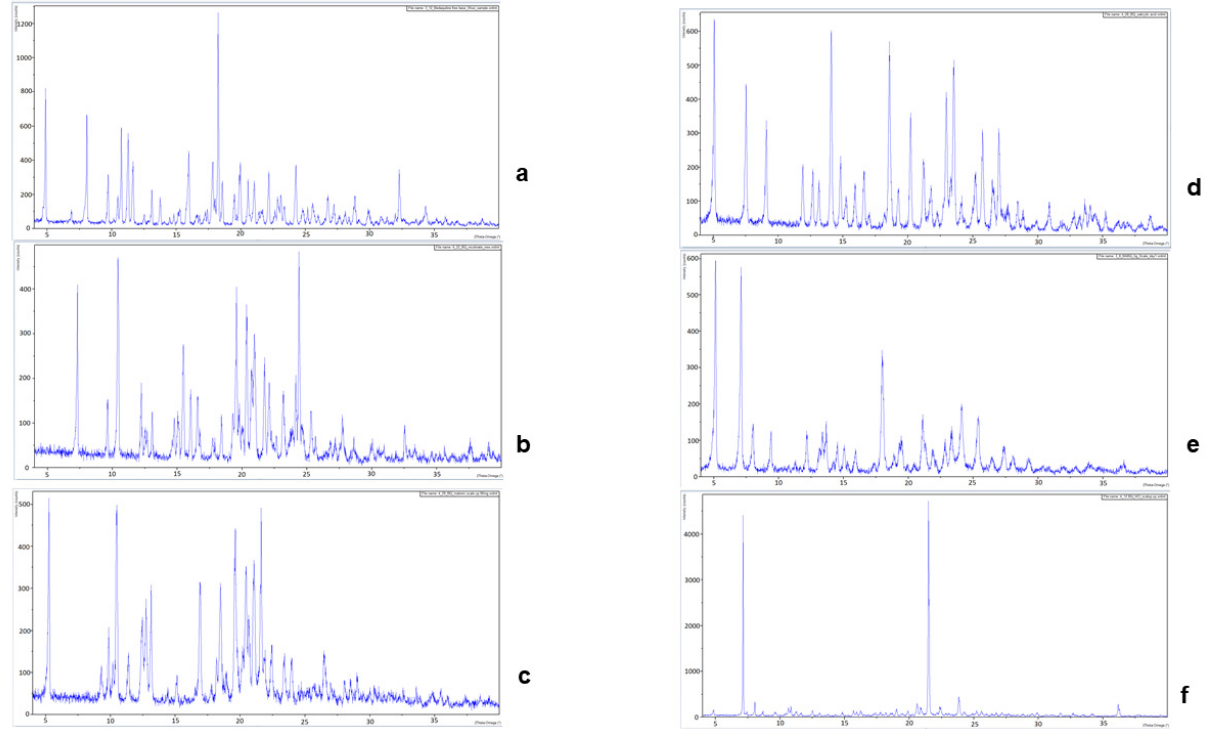
Figure 2. The samples’ intensities, measured over a 2 θ domain from 4° to 40° θ , generated distinctive PXRD patterns for the bedaquiline free base and its salts. ( a ) Bedaquiline free base, ( b ) nicotinate, ( c ) malonate, ( d ) salicylate, ( e ) benzoate hydrate, ( f ) HCl.